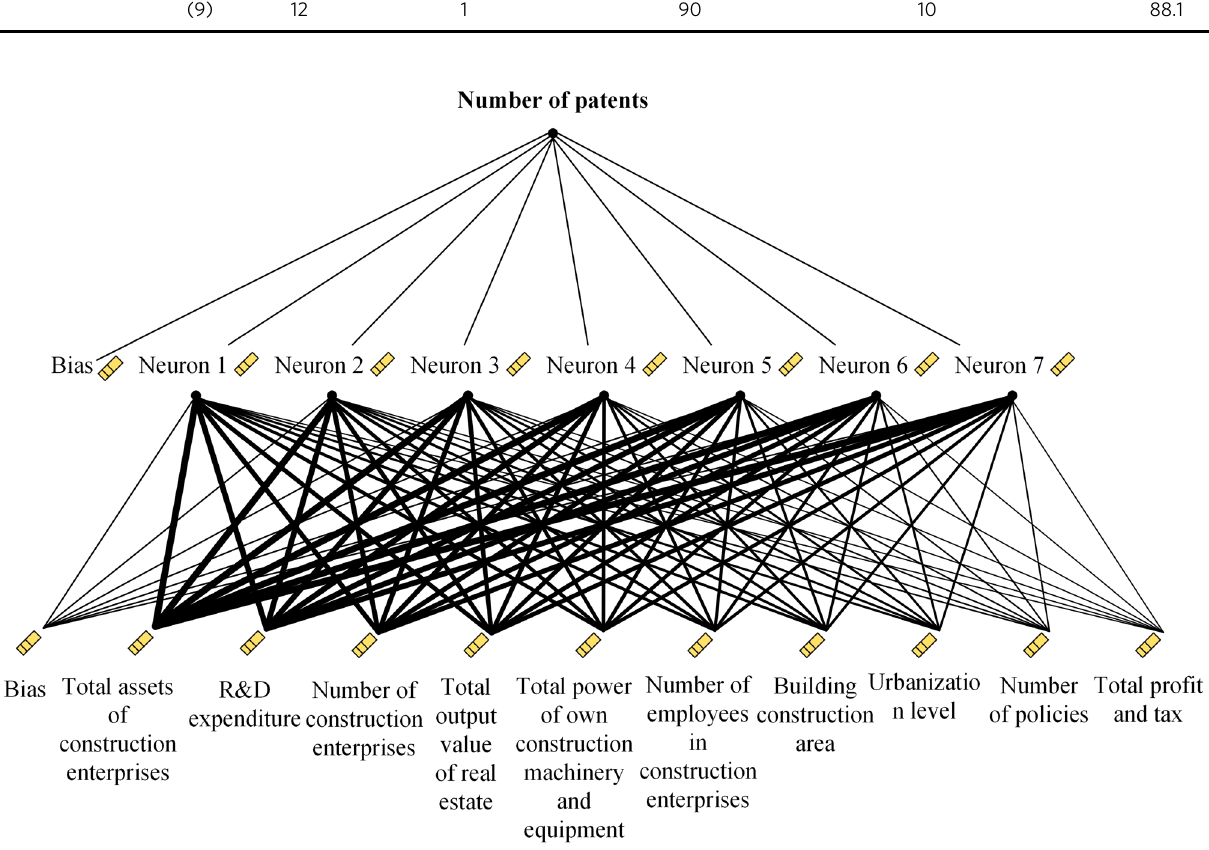
Fig. 4 Arti fi cial neural network model of in fl uencing factors of construction enterprises ’ adoption of green development behaviors. The arti fi cial neural network model is composed of input layer, hidden layer and output layer from top to bottom. The input layer has 10 predictive variables and 1 bias, the hidden layer has 7 neurons and 1 bias, and the output layer has 1 target